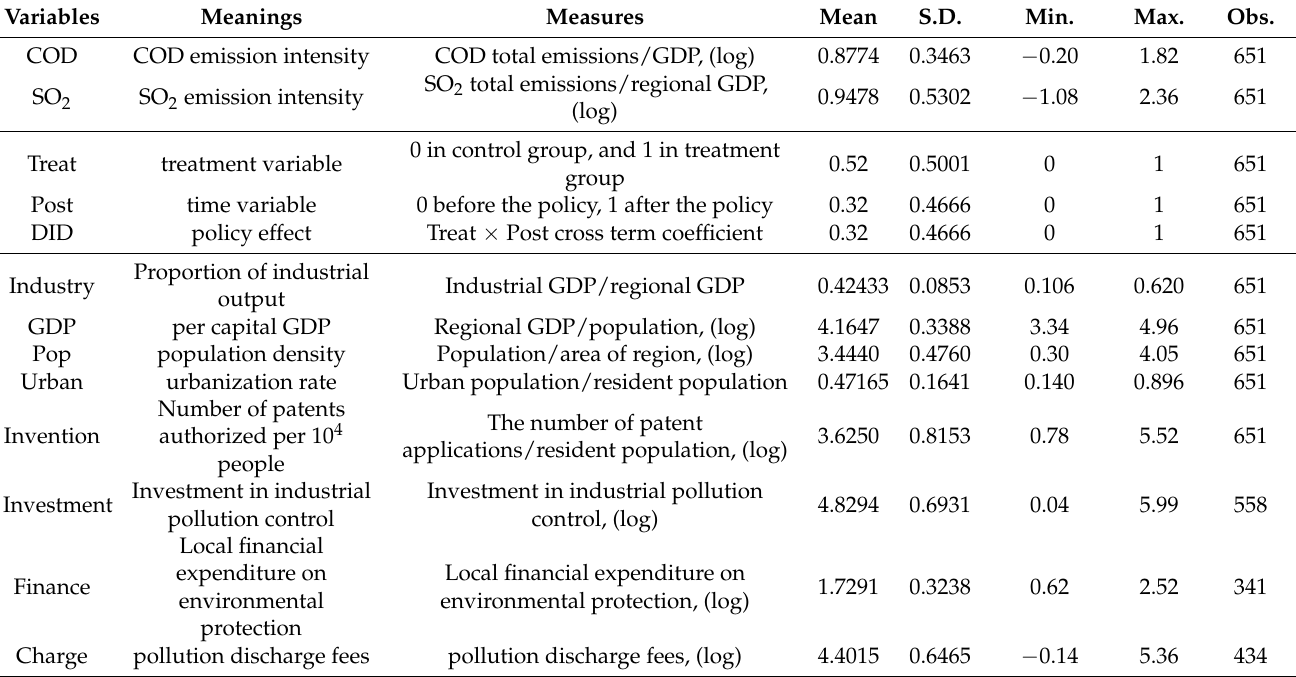
Table 1. Main Variables, meanings, and descriptive